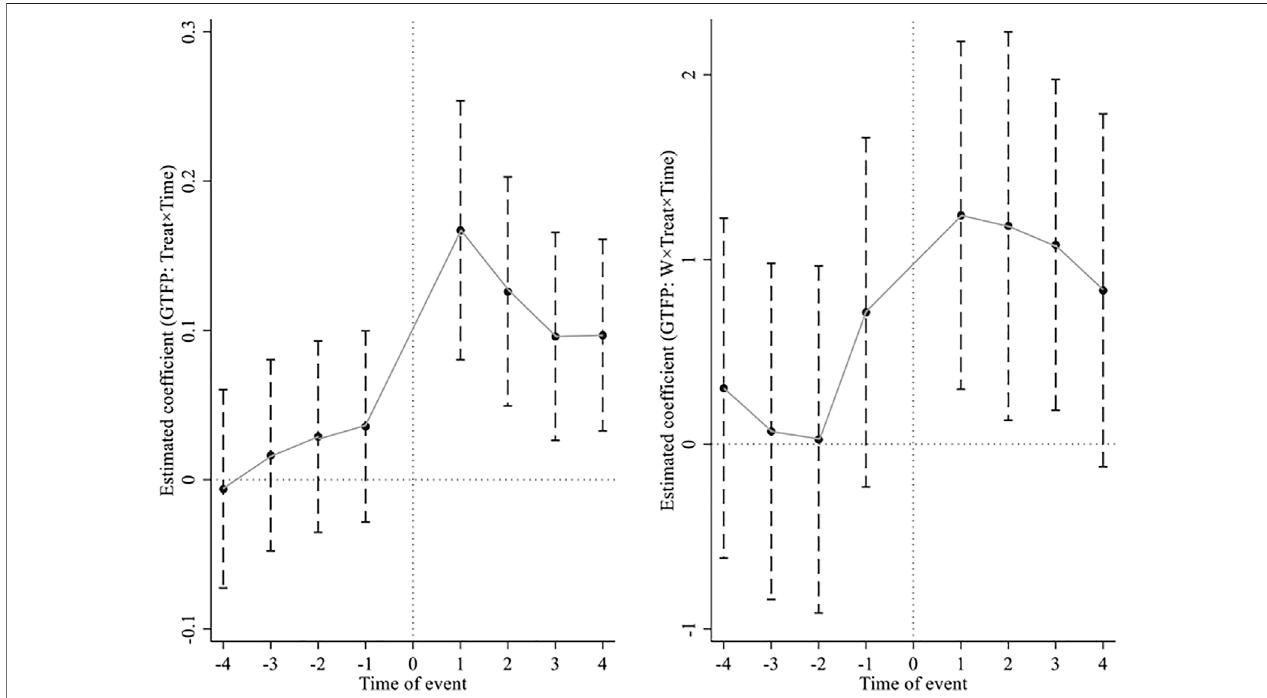
FIGURE 4 | Parallel trend test results of